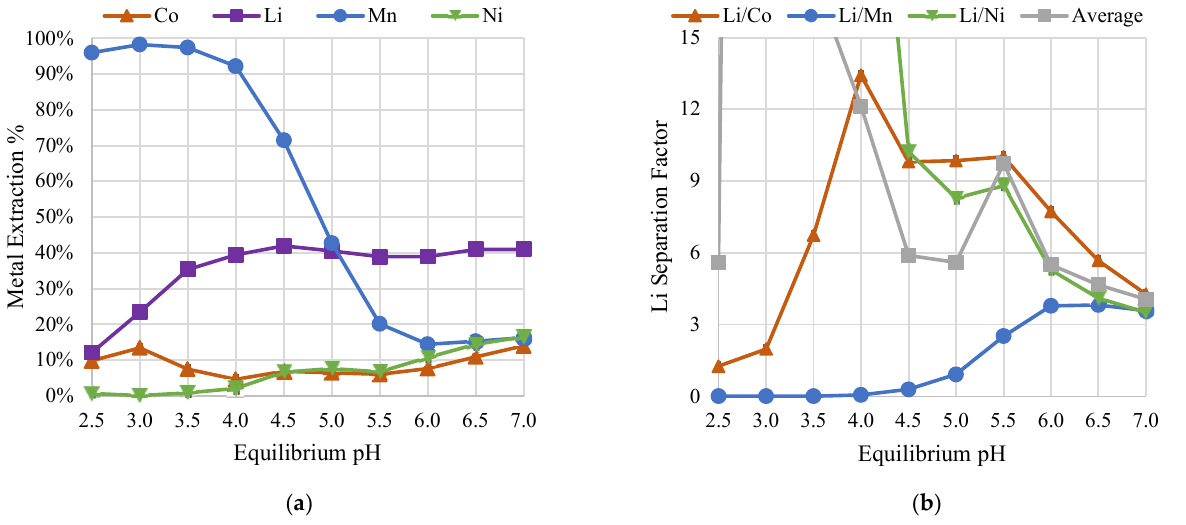
Figure 5. ( a ) Metal extraction and ( b ) Li separation factor with 0.9 M D2EHPA and O/A 1.